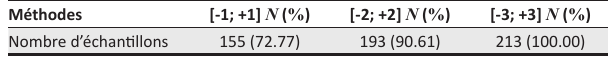
TABLEAU 2: Nombre d’échantillons selon les différences du taux d’hémoglobine entre les deux méthodes. Méthodes